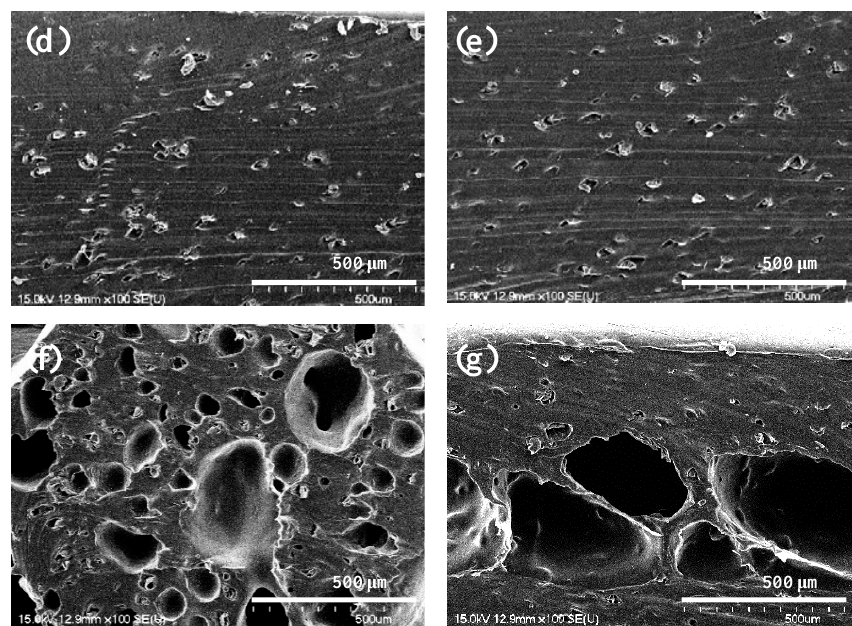
Figure 2. SEM images (X100) of polyester thermoplastic film with various contents of thermally expandable microcapsules: ( a ) 0%, ( b ) 1%, ( c ) 3%, ( d ) 5%, ( e ) 7%, ( f ) 9%, and ( g ) 11%, respectively. Polymers 2019 , 11 , x FOR PEER REVIEW